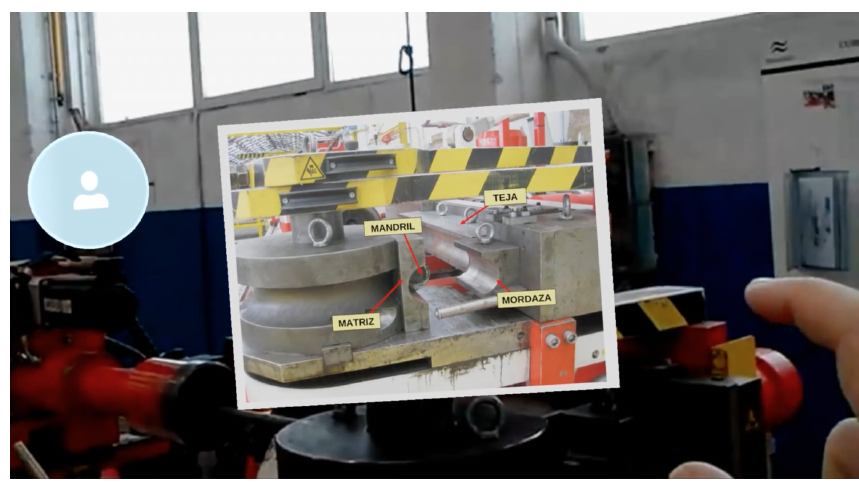
Figure 5. Microsoft HoloLens collaborative IAR